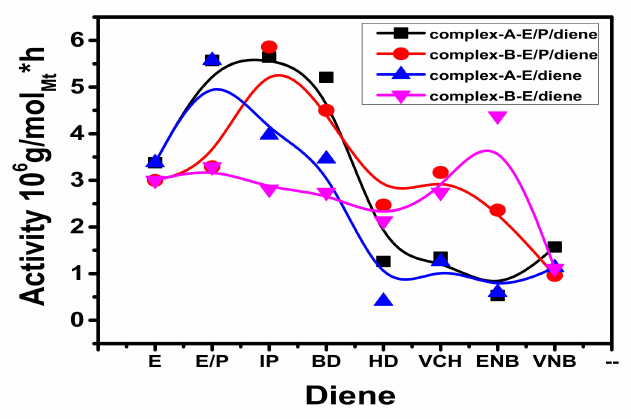
Figure 6. The activity of ethylene/propylene diene (conjugated and nonconjugated) terpolymeriza- tion with complex A and complex B at ethylene 80/20 mol% and 0.06 mol/L